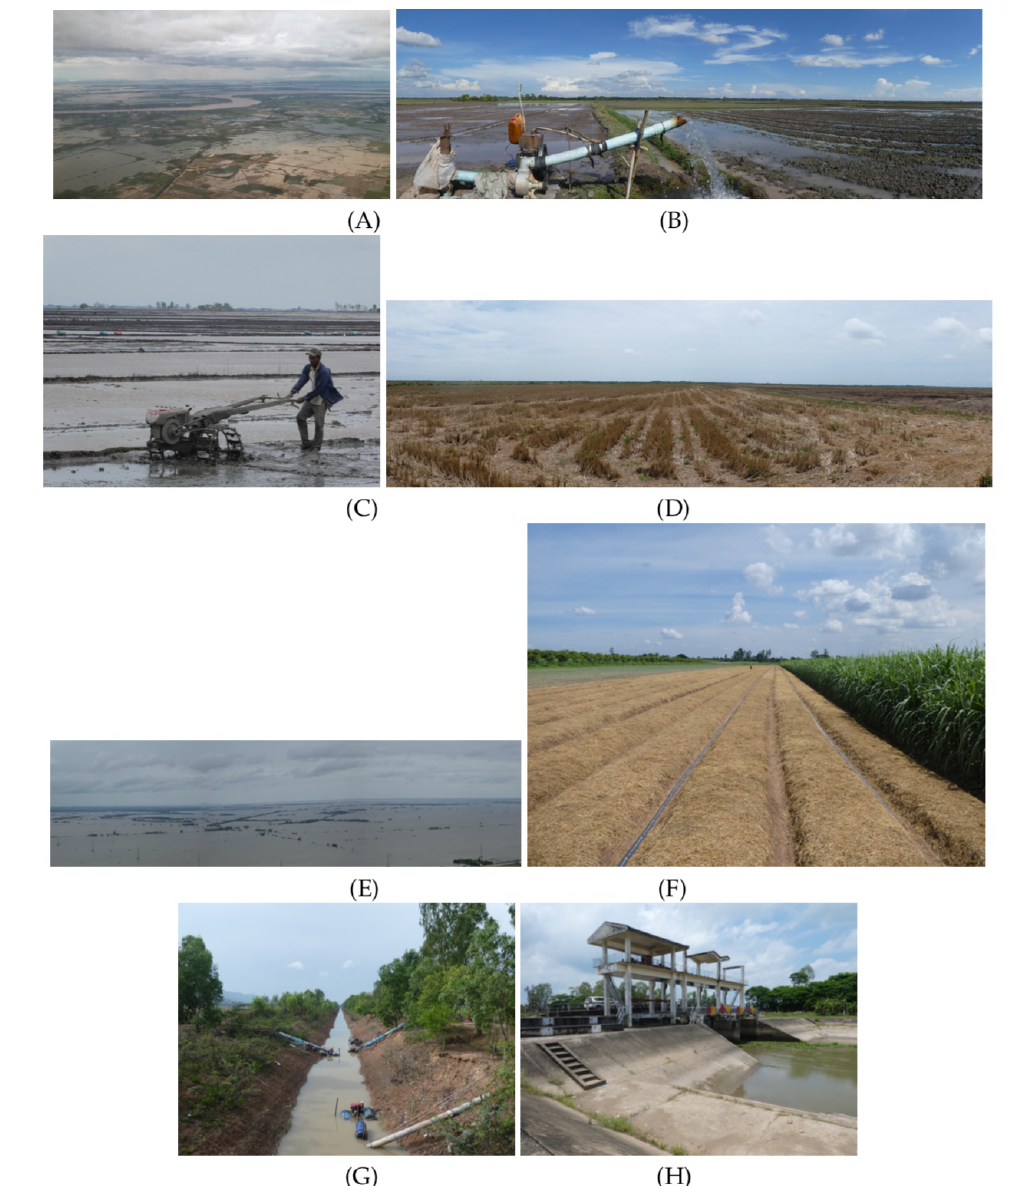
Figure 2. ( A ) The floodplain in Kandal province, Cambodia, October 2017; ( B ) Watering rice fields for recession rice, September 2017, representative of zone 3C; ( C ) Preparing rice fields for recession rice, November 2017, zone 1C; ( D ) Dry rice fields in Prey Veng province, Cambodia, May 2018, zone 3C; ( E ) The PRASAC area under water during a normal flood year, Takeo Province, Cambodia, September 2018, zone 3C; ( F ) Vegetable fields in Kandal Province, Cambodia, September 2017, zone 2C); ( G ) An earthen drainage channel in Takeo province, Cambodia, May 2018, zone 3C; ( H ) A sluice gate in An Giang province, Vietnam, May 2018, zone 2V (Photo credit: Jean-Philippe